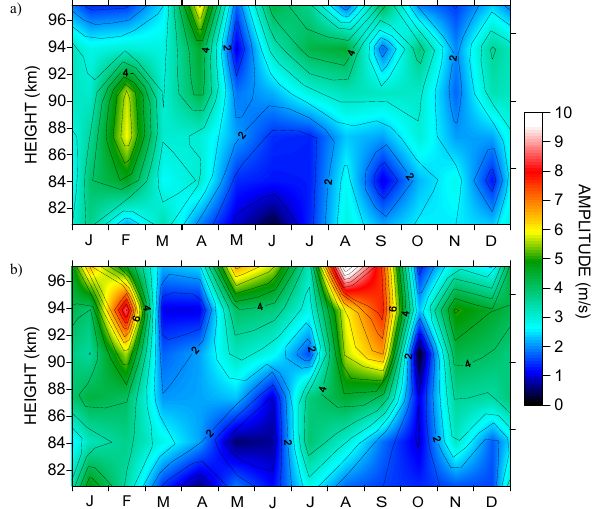
Fig. 2. Contour plot of the Lunar M 2 tidal amplitude calculated form monthly-mean amplitudes (vector averaged to give the sea- sonal variation) of zonal and meridional wind data over the period 2001–2005 from the Ascension Island meteor radar. Colour scale indicates